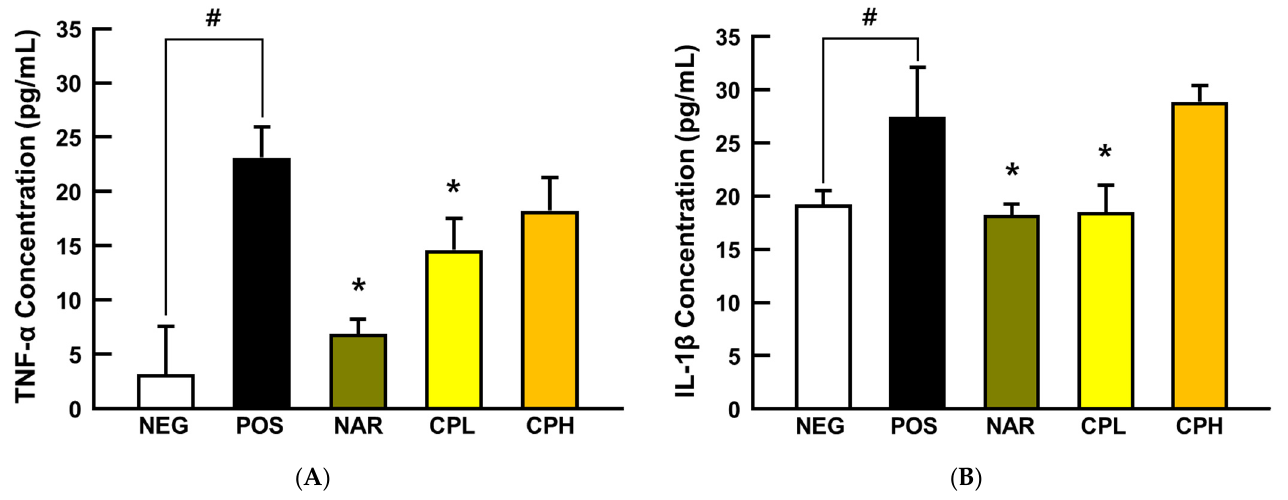
Figure 4. The expression of pro-inflammatory cytokines in the BALF from PM 10 -treated mice. ( A ) TNF- α and ( B ) IL-1 β protein expression. All values are expressed as mean ± SEM. p- value less than 0.05 was considered statistically significant. # indicates statistical significance compared to the NEG group and * indicates statistical significance compared to the POS group. CPL, Citrus junos Tanaka peel extract low concentration; CPH, Citrus junos Tanaka peel extract high concentration; NAR, naringin; NEG, negative control; POS, positive control.